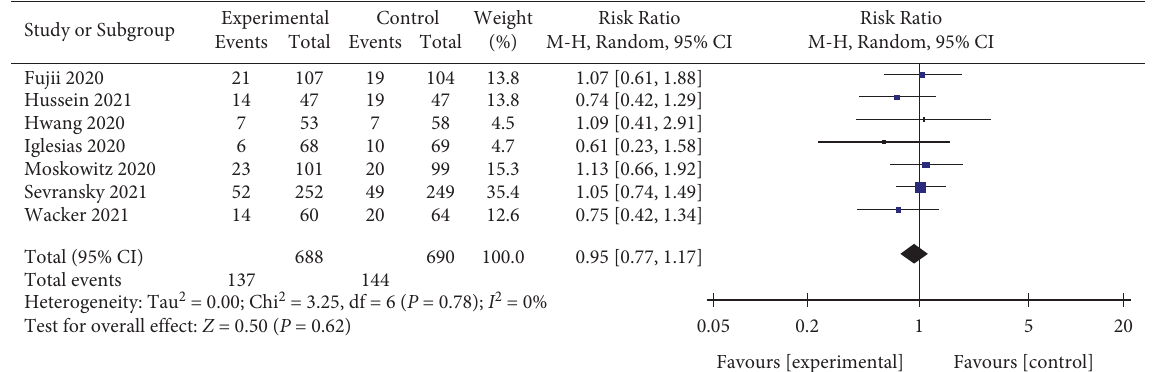
Figure 9: Forest plots for the efect of vitamin C on ICU mortality.